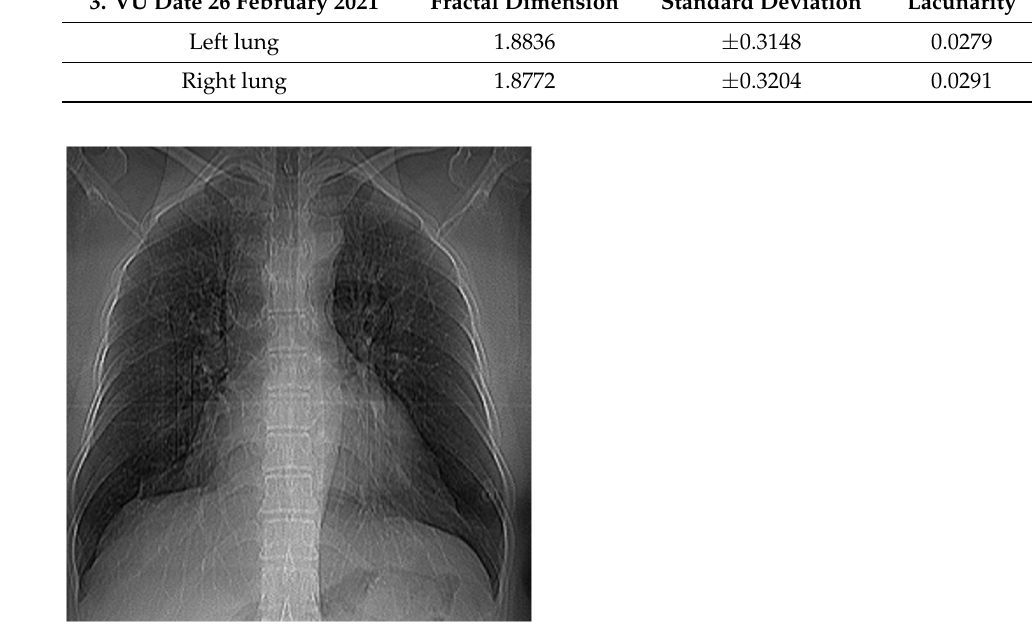
Figure 12. Selecting the portion of interest of the lungs of patient VU.